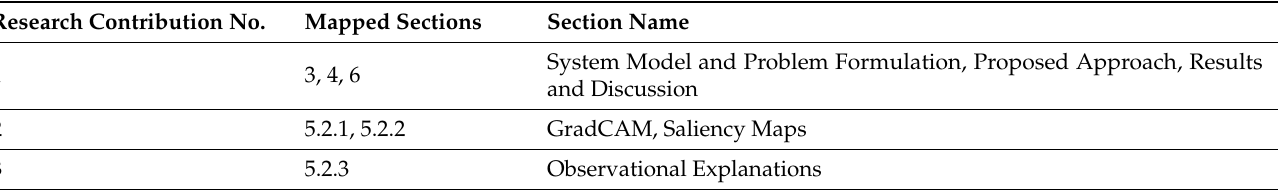
Table 2. Contribution mapping with respective sections in the